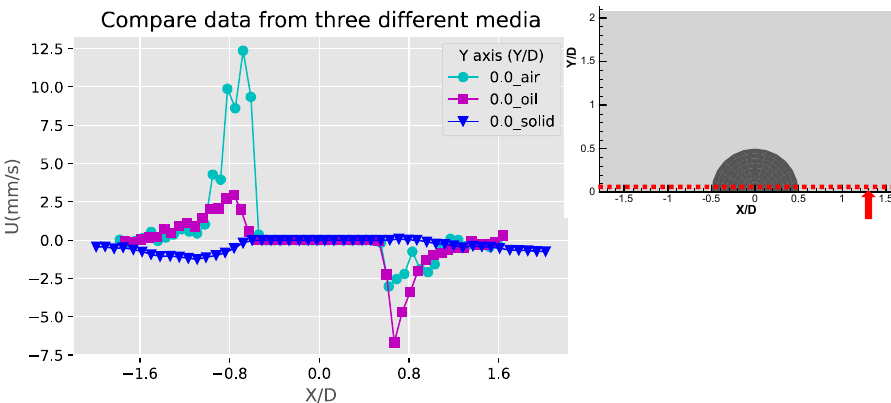
Figure 9. Comparison of the X-component velocity (U) profiles at the base of the obstructions (Y/D = 0).